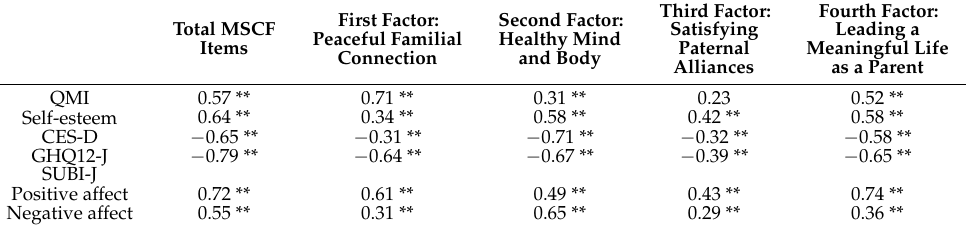
Table 5. Correlations among the MSCF and five scales (N = 92). Total MSCF